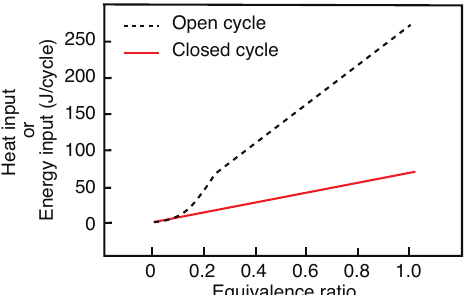
Figure 5. Relationship between the heat input and equivalence ratio for the reference actuator for open and closed cycle